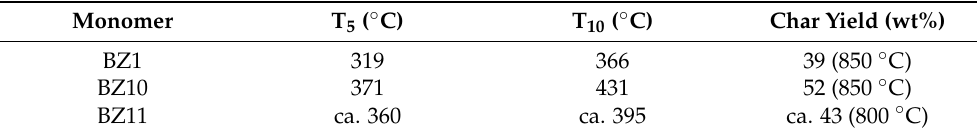
Table 1. Thermal properties of polybenzoxazines derived from BZ1, BZ10, and BZ11 [39,40].